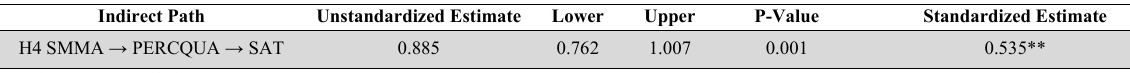
Indirect Effect Indirect